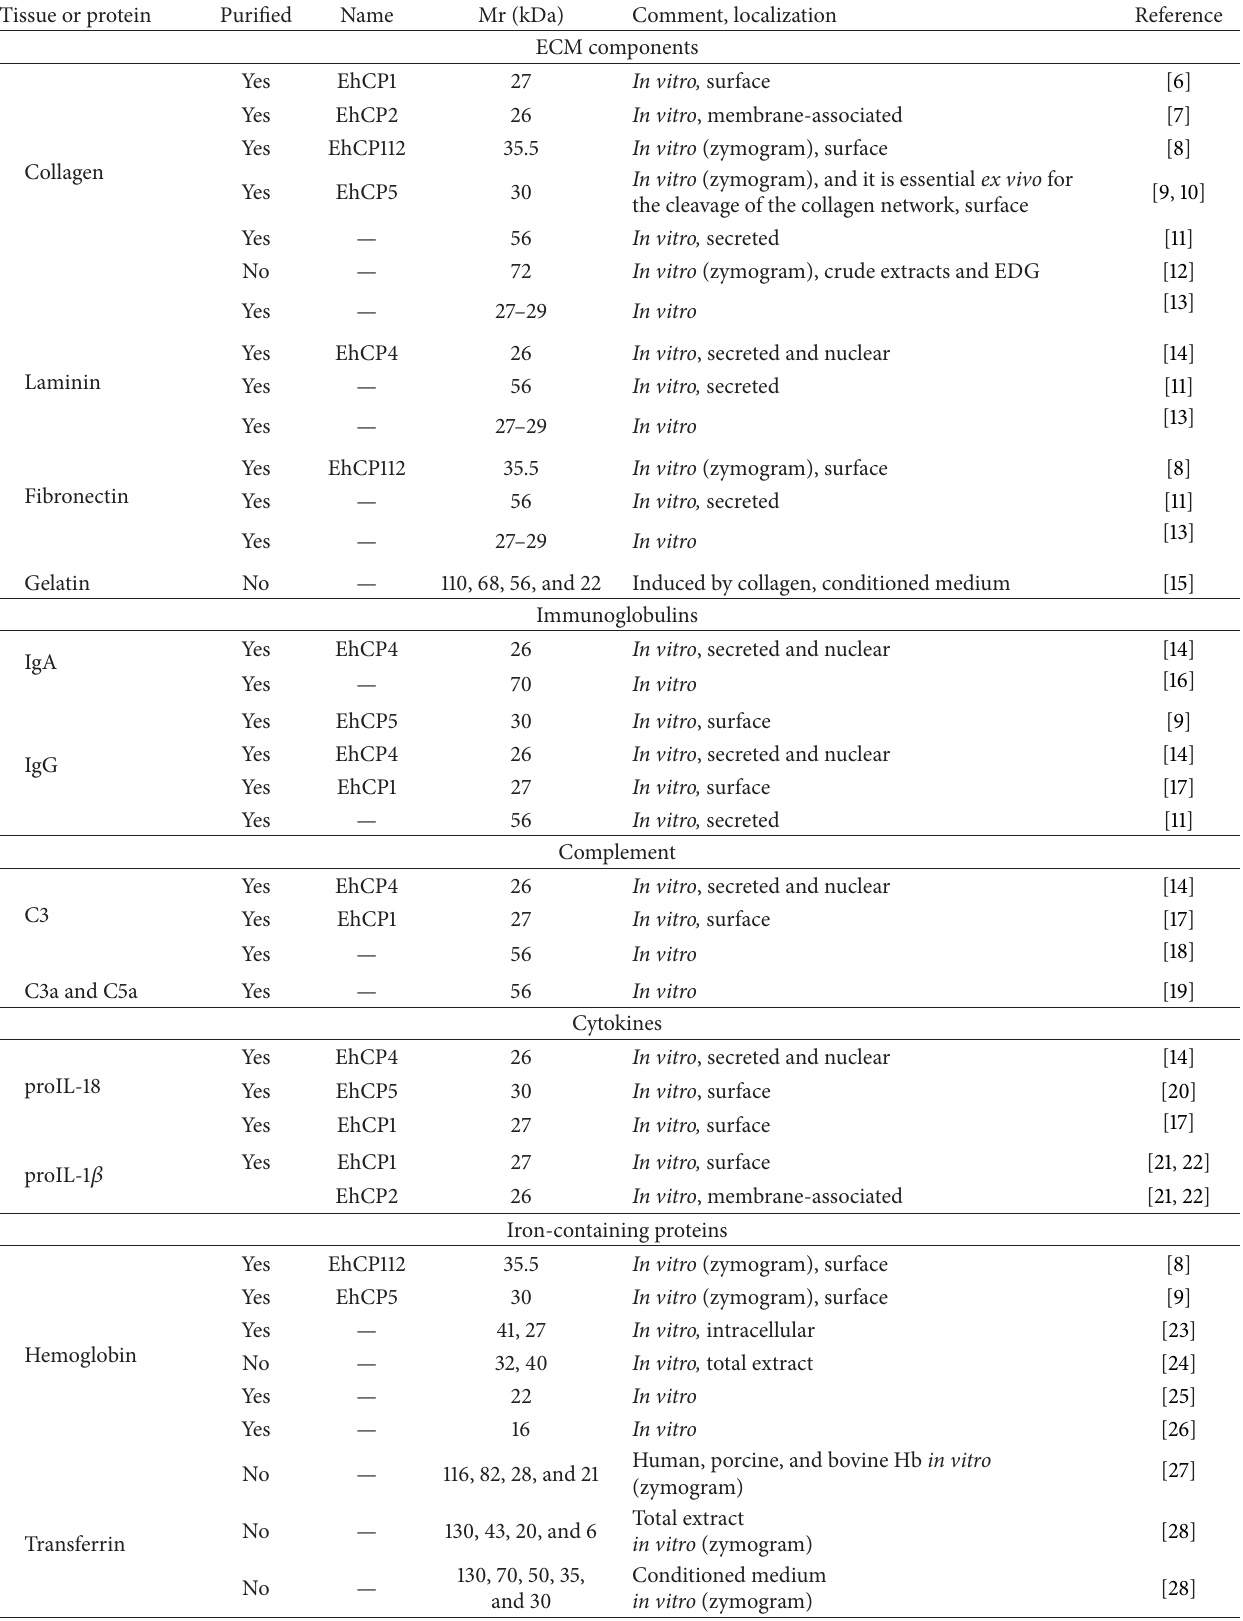
Table 1: Cysteine proteases of Entamoeba histolytica that degrade host proteins and their implication in virulence. Tissue or